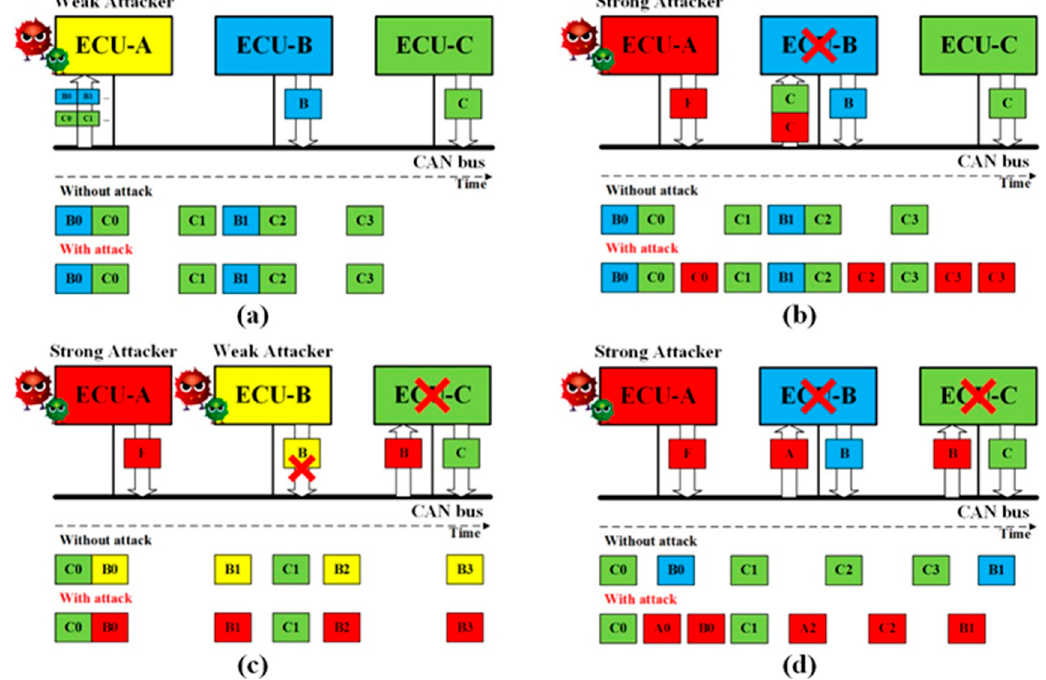
Figure 3. Basic four attack vectors [17]: ( a ) Eavesdrop attack; ( b ) Replay attack; ( c ) Impersonation attack; ( d ) Injection attack.